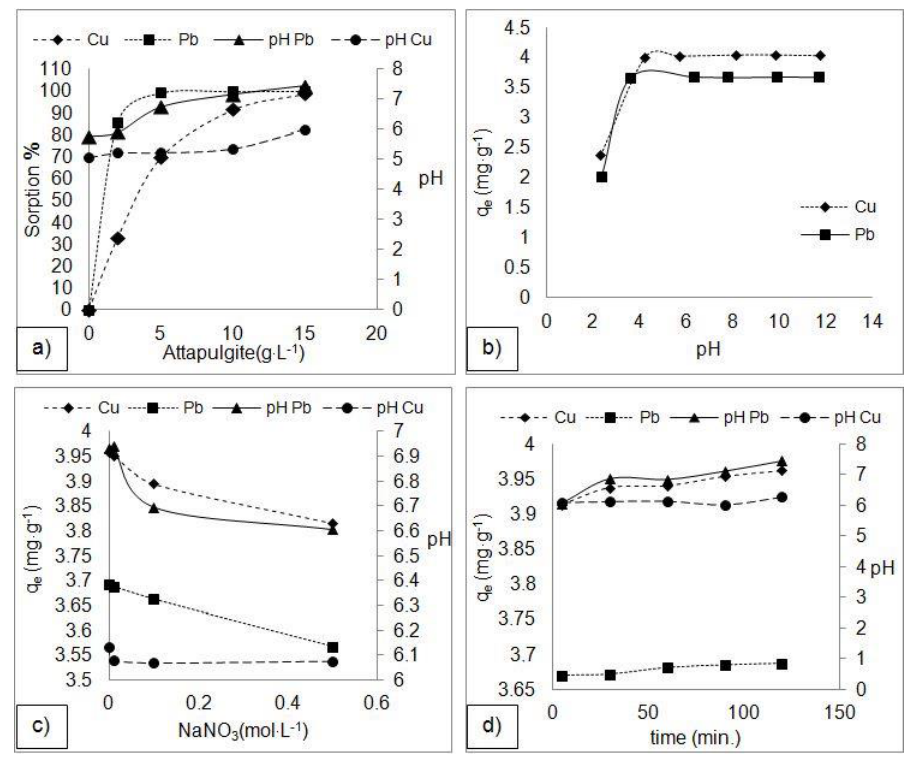
Figure 3. Diagrams of adsorption capacity for different parameters: ( a ) attapulgite mass versus adsorption (%) of Pb and Cu, ( b ) effect of pH of initial suspension on adsorption of Pb and Cu, ( c ) effect of ionic strength on adsorption of Pb and Cu, and ( d ) effect of shaking time on adsorption of Pb and Cu.